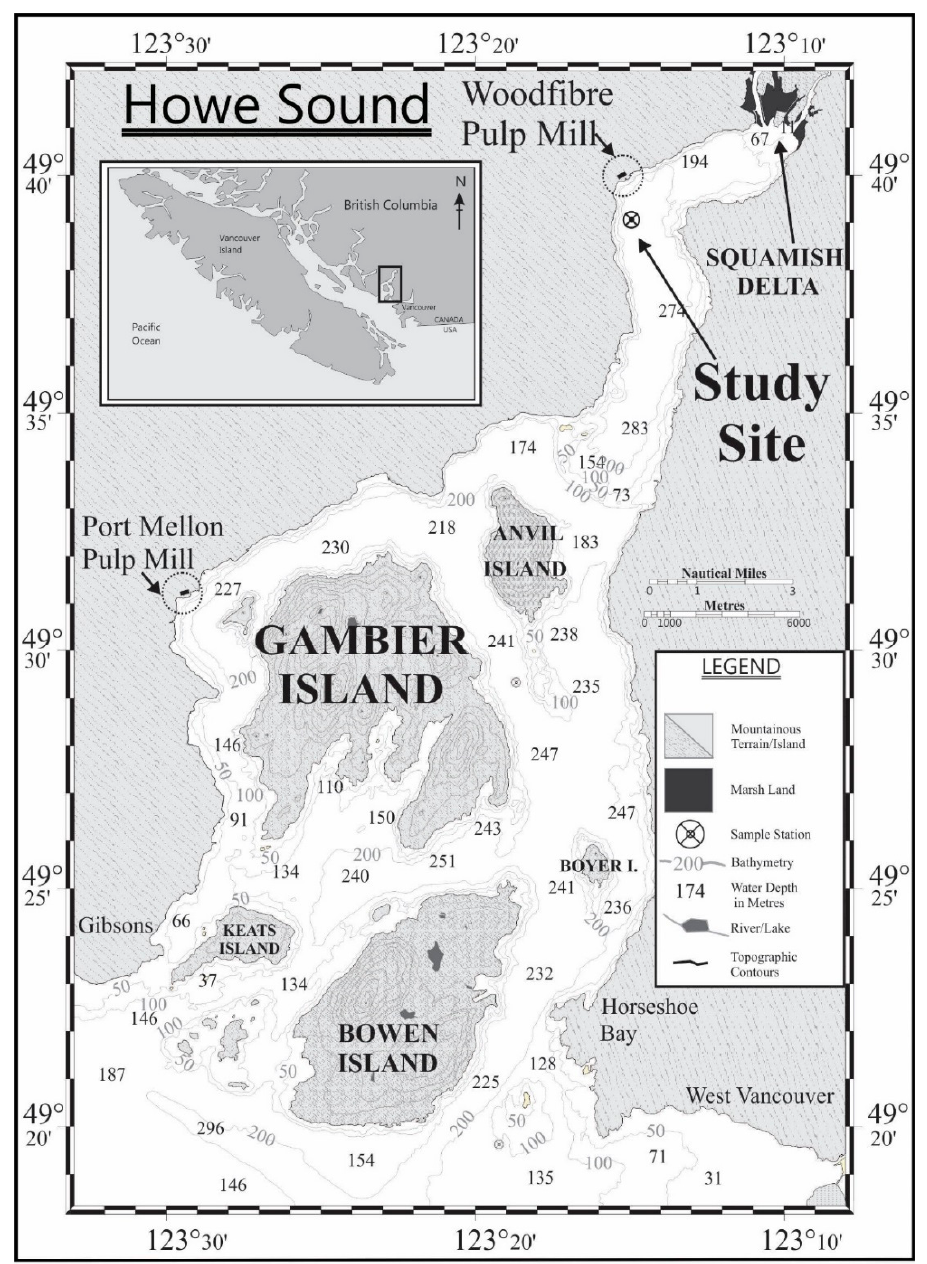
Figure 1. Map showing the location of the sample site in Howe Sound, BC, Canada.